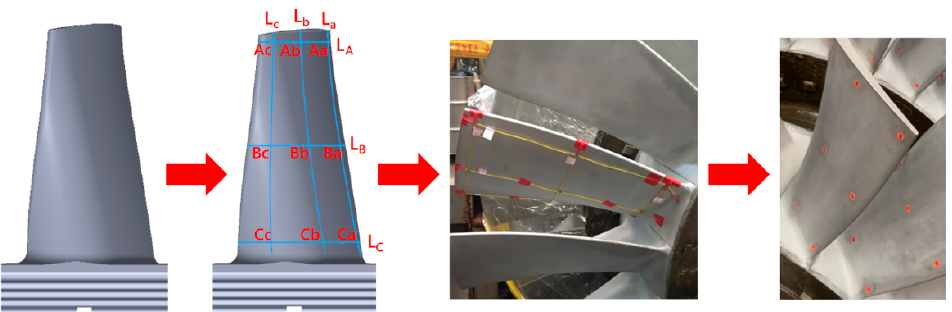
Figure 10. The arranged measurement points of blade in modal testing.